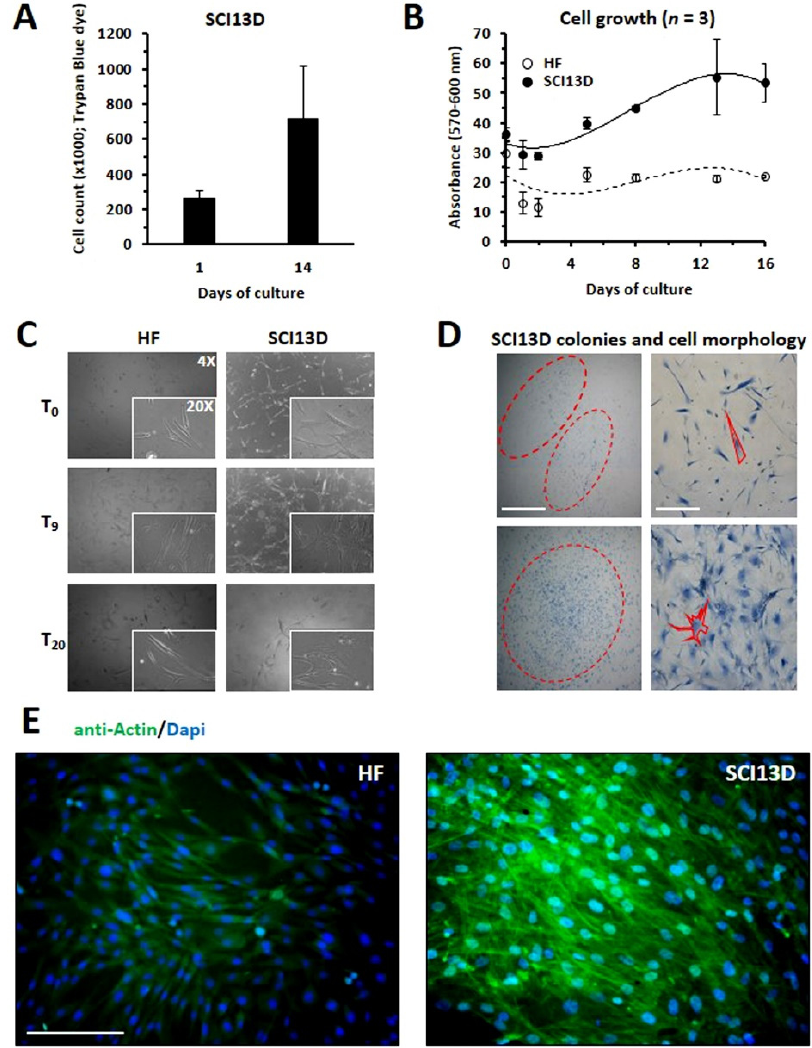
Figure 2. Determination of proliferation and morphological characterization of SCI13D as compared to control fibroblasts. Determination of SCI13D cell line proliferation by ( A ) trypan blue dye exclusion (histograms are the mean of three experiments ± SD), or ( B ) Alamar Blue TM test at different timepoints; ( C ) Morphological representation of growing SCI13D fibroblasts or of control fibroblasts (HF) as observed in bright field; ( D ) SCI13D colony and cell morphology after fixation and staining with Methylene Blue; scale bar = 10 µ m; ( E ) actin/DAPI immunofluorescence staining of control fibroblasts (HF) and of SCI13D cell line after their culture in chamber slides; scale bar = 12.5 µ